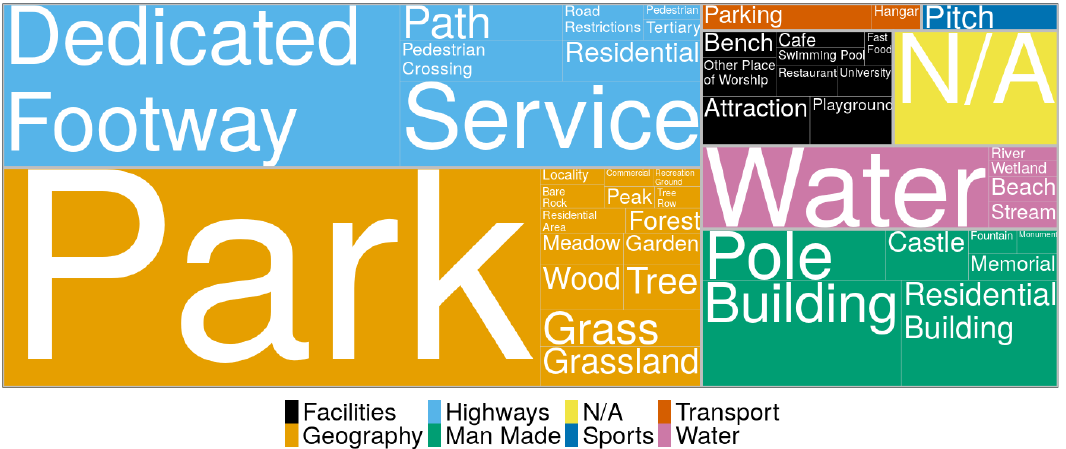
Figure 10. Newly created OSM features classified according to the JOSM default preset.